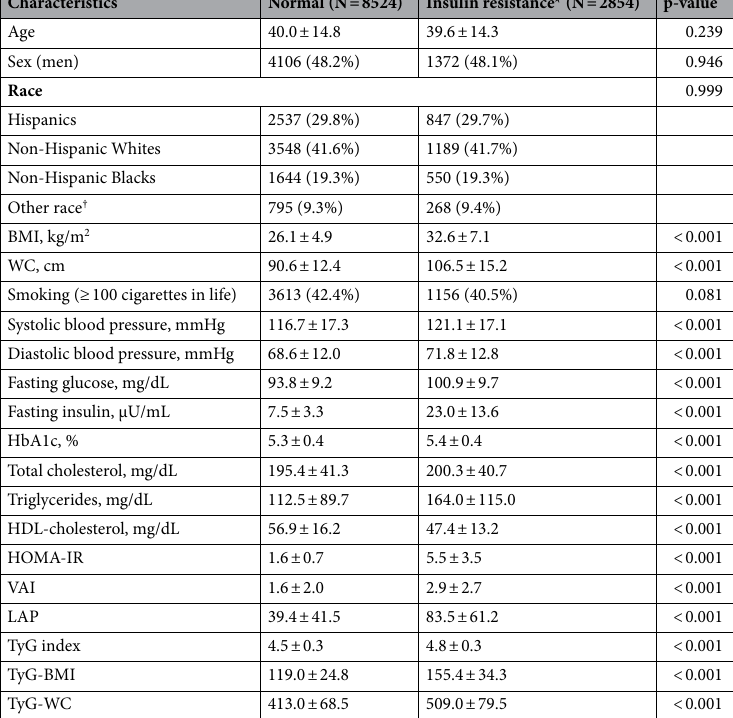
Table 1. Baseline characteristics of the participants in NHANES 1999–2016. Data are presented as mean ± standard deviation or number (%). BMI body mass index, WC waist circumference, BP blood pressure, HbA1c hemoglobin A1c, HDL high-density lipoprotein; HOMA-IR homeostasis model assessment-insulin resistance, VAI visceral adiposity index, LAP lipid accumulation product, TyG index triglycerides and glucose index. *Insulin resistance was defined as a HOMA-IR value above the 75th percentile for each sex and race/ ethnicity. † Other race included non-Hispanic Asian and multi-racial